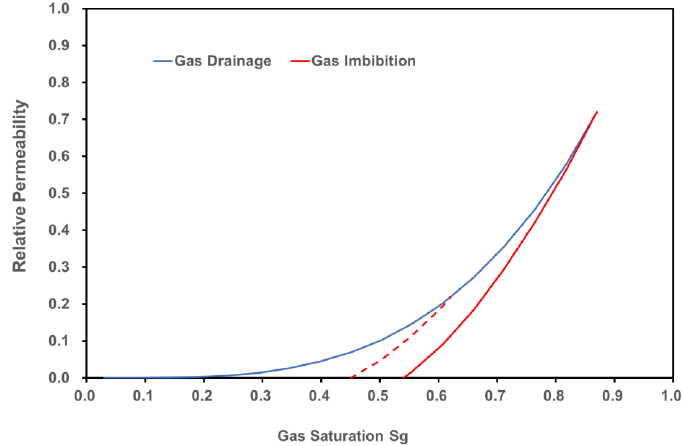
Figure 15. Carlson hysteresis model on the non-wetting gas phase.